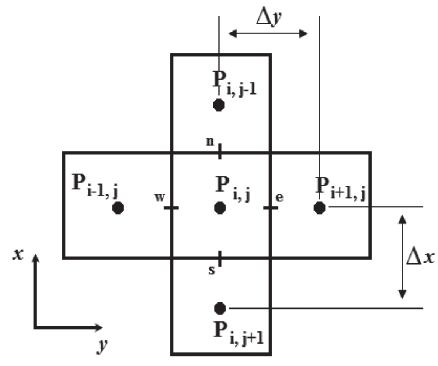
Figure 1 - Bearing with discontinuities in the radial clearance. Figure 2 - Finite volume